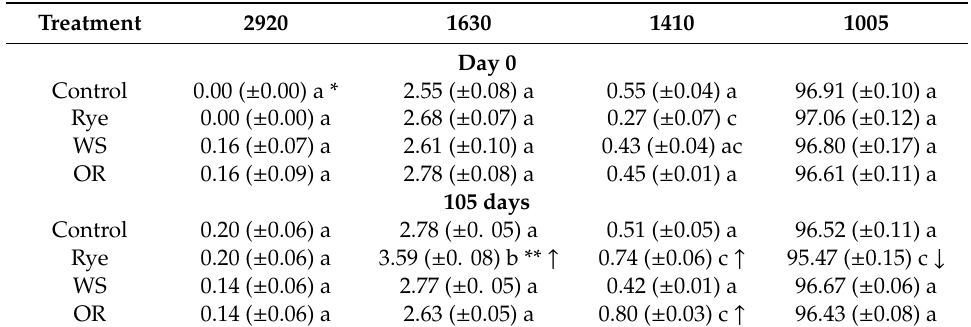
Table 4. Di ff erences in relative absorbance (%) from the FTIR spectra (mean ± standard error) in di ff erent treatment conditions: Control, OR (soil mixed with oilseed rape residues), Rye (soil mixed with rye residues), and WS (soil mixed with wheat straw residues), at Day 0 (before residue incorporation) and at Day 105.